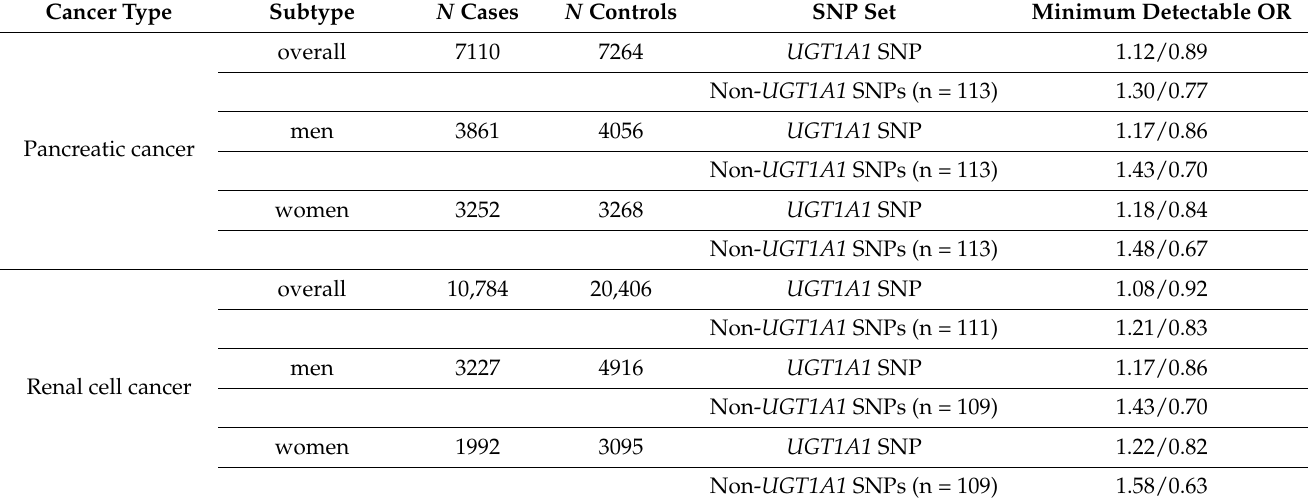
Table 1. Summary information of cancer GWAS samples and power